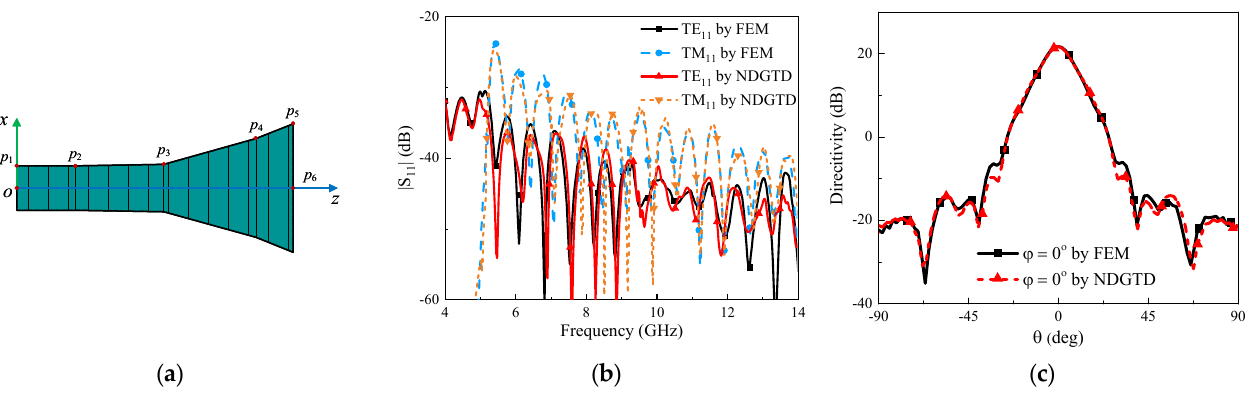
Figure 6. Dual-mode circular horn antenna: ( a ) topology, ( b ) S-parameters, and ( c ) directivity at 10GHz. The contour of the horn is a polygon formed by connecting the following points in turn: o (0, 0, 0), p 1 (35.5 mm, 0, 0), p 2 (35.5 mm, 0, 90 mm), p 3 (38 mm, 0, 226 mm), p 4 (78 mm, 0, 366 mm), p 5 (101 mm, 0, 423 mm), and p 6 (0, 0, 423 mm).